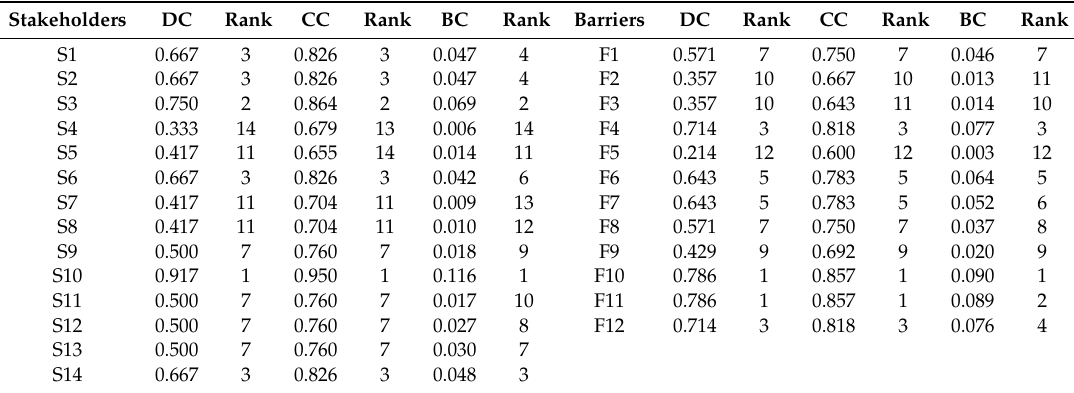
Table 2. The centrality of nodes in the stakeholder–barrier